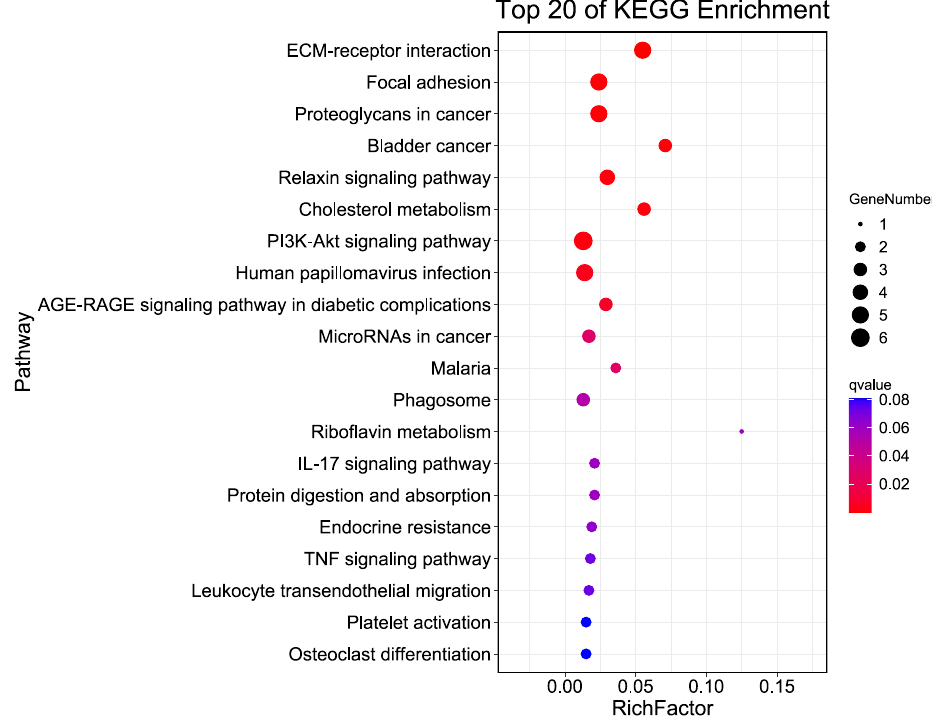
Figure 5. Kyoto Encyclopedia of Genes and Genomes (KEGG) pathway analysis of hub genes. The x-axis label represents the gene ratio (Rich factor) and the y-axis label represents the pathway.